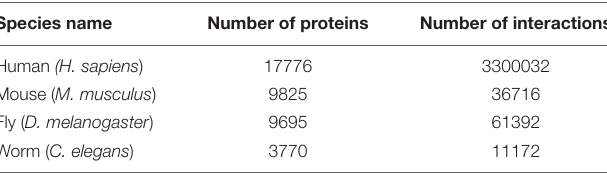
TABLE 2 | Physical protein-protein interaction network (PPIN) details for four